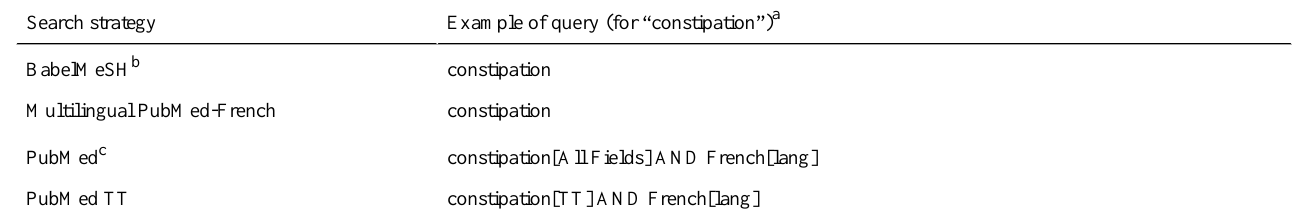
Example of query (for “constipation”) a Search strategy